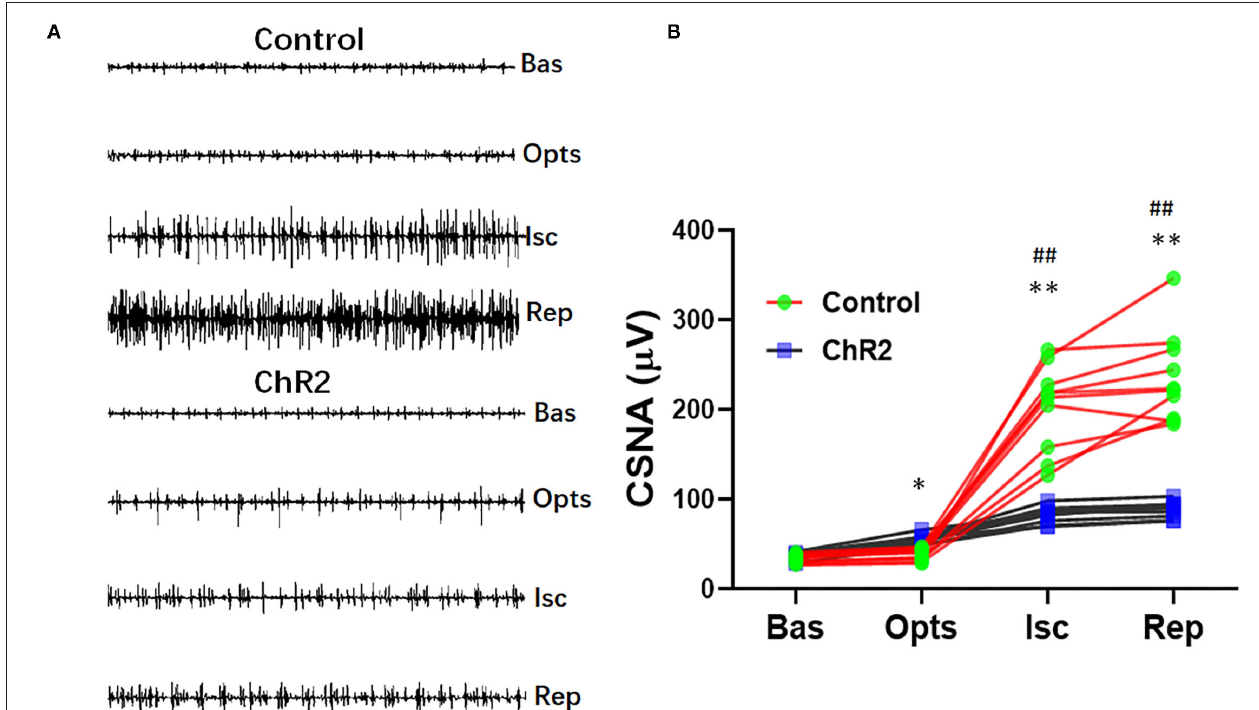
FIGURE 4 | Selective optical stimulation of the dorsal horn prevents cardiac sympathetic hyperactivity during myocardial ischemia-reperfusion. (A) Representative traces of cardiac sympathetic nerve activity (CSNA) during 15min of ischemia and 30min of reperfusion from control and ChR2 rats. (B) Quantitative analysis of CSNA at baseline (Bas), optical stimulation (Opts), ischemia (Isc), and reperfusion (Rep). Data are expressed as mean ± SD. A paired t -test was used to compare parameters before and after optical stimulation and a t -test was used to compare differences between the ChR2 and control groups ( n = 10 per group; * P < 0.05, ** P < 0.01 vs. Control; ## P < 0.01 vs.